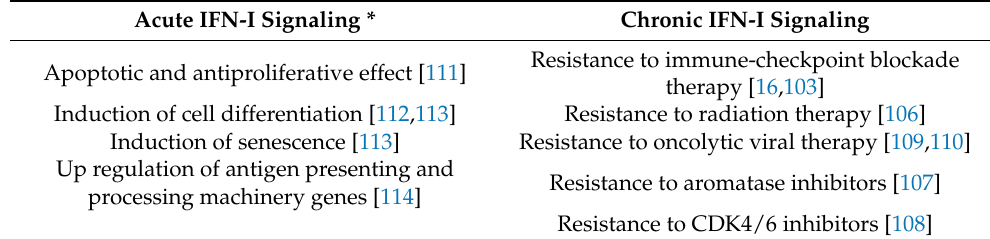
Figure 3. Actin cytoskeletal deregulation and viral mimicry in cancer. In cancer cells actin cy- toskeleton rearrangements constantly occur during tumor progression and could be perceived as an alteration of homeostasis that resembles a viral infection. This viral mimicry induces RLRs signaling activation, culminating with IFN-I production. Depending on the context, acute or chronic IFN-I signaling may have opposite effects in cancer. Table 1. Effects of acute and chronic IFN signaling in